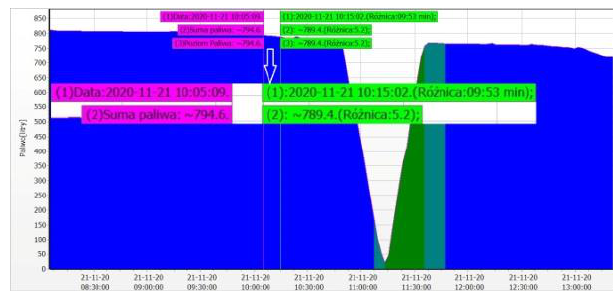
Fig. 6. Measurement of hourly fuel consumption FC [l/h] of a CAT C27 engine (6Dg locomotives) without additive. Test F, point 